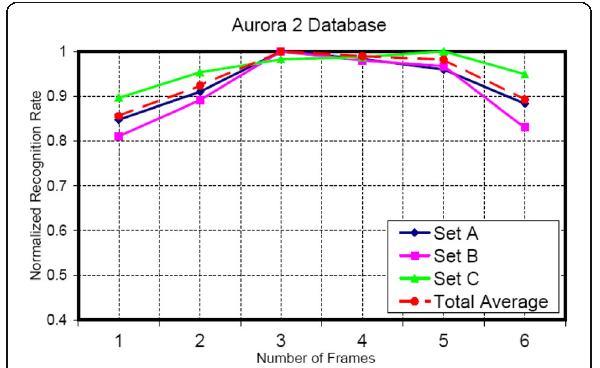
Fig. 7 Normalized recognition rates for test sets of Aurora 2 task versus the number of frames used in noise autocorrelation sequence averaging and their grand